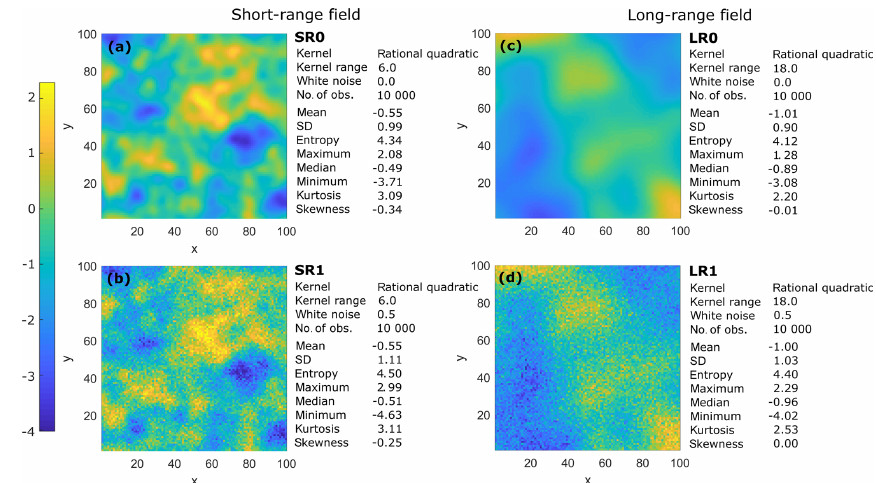
Figure 4. Synthetic fields and summary statistics. (a) Short-range field without noise (SR0), (b) short-range field with noise (SR1), (c) long- range field without noise (LR0), and (d) long-range field with noise